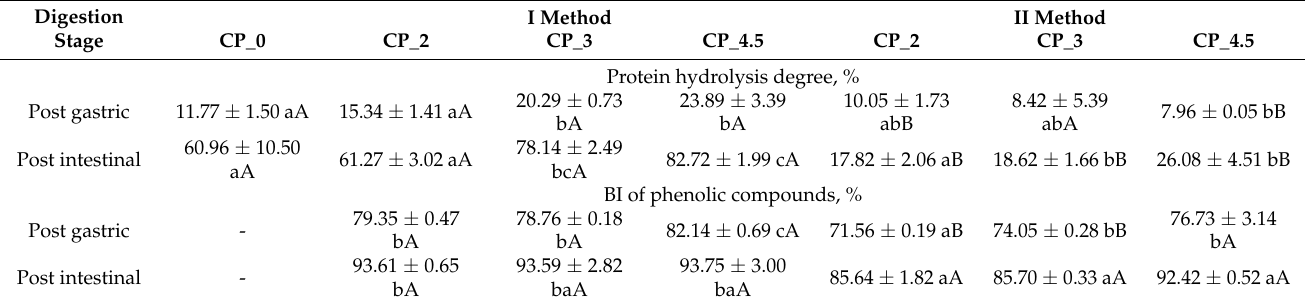
Table 4. Digestibility characteristics of yogurt made by adding different amounts of CP after (I method) and before fermentation (II